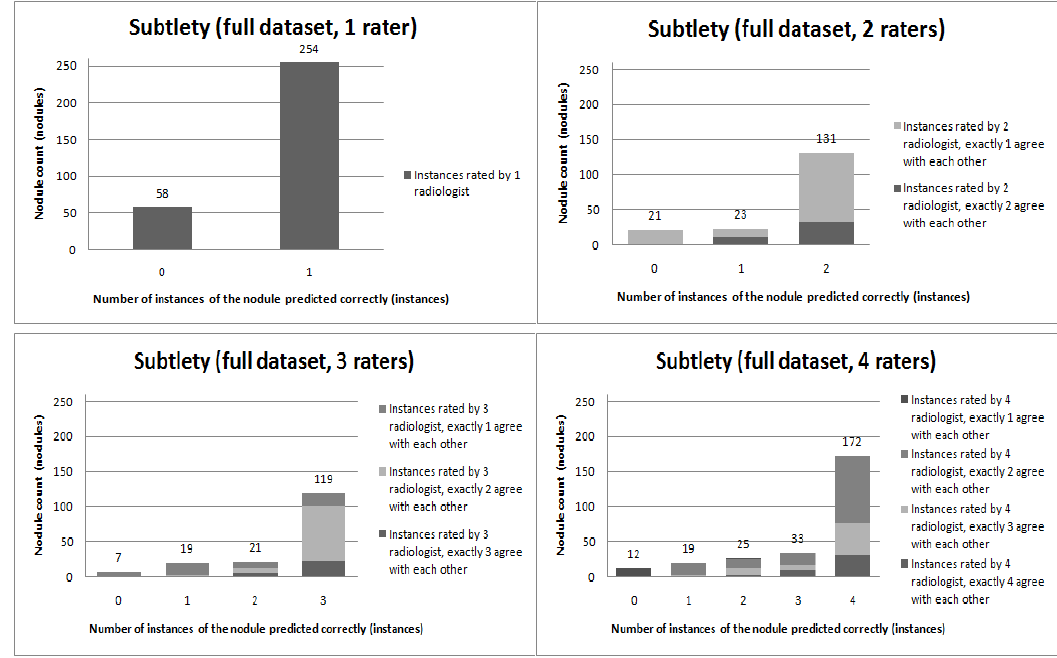
Figure 11. Visual overview of the ensemble of classifiers’ agreement with the panel of experts’ opinions